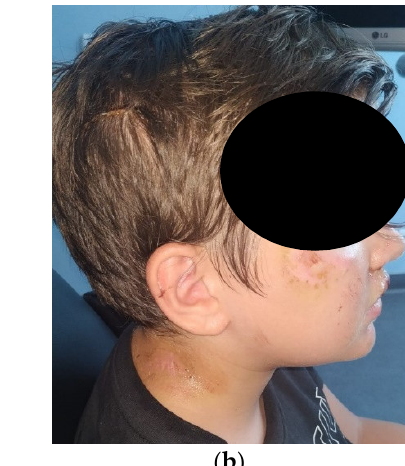
Figure 2. ( a ) Orofacial trauma with upper lip laceration; ( b ) Extension of lesions on the cranio– cervico–mandibular complex.